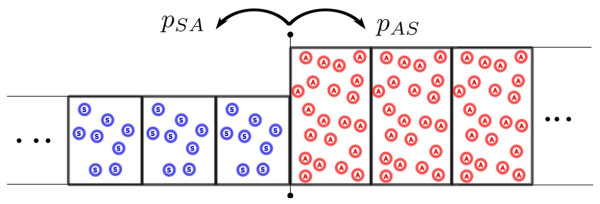
Geographically structured populations.Geographically structured population where patches can exchange migrants. For low migration rates, the border between A and S domains can be modeled as a biased random walk.